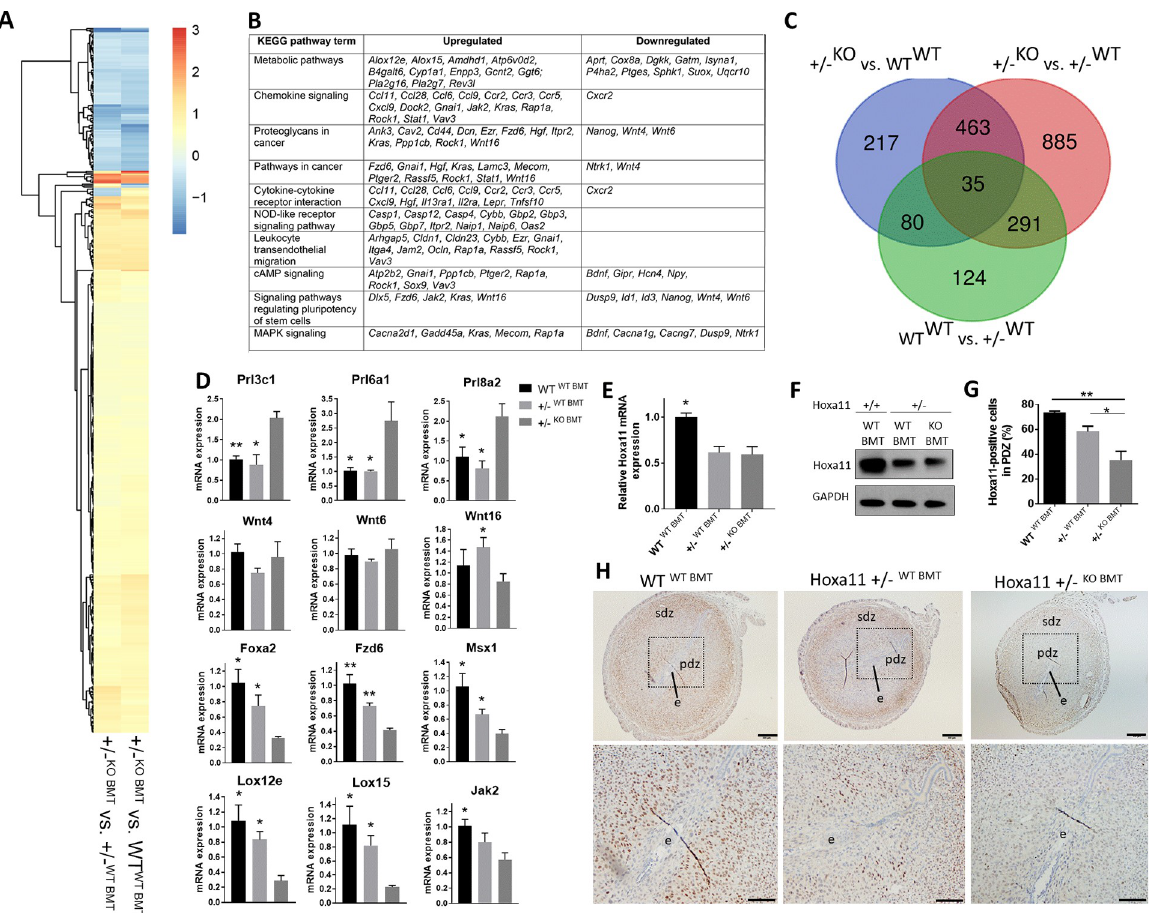
Fig 5. BM transplantation from WT donors normalizes the uterine transcriptome of Hoxa11 +/ − mice. (A-C) RNA-seq analysis of implantation sites on E5.5 in Hoxa11 +/ − WTBMT , Hoxa11 +/ − KO BMT , and WT WT BMT . (A) Heat map of the expression fold change of 498 commonly DEGs in the comparisons of Hoxa11 +/ − KO BMT versus Hoxa11 +/ − WT BMT , and Hoxa11 +/ − KO BMT versus WT WT BMT . (B) The top 10 KEGG pathways